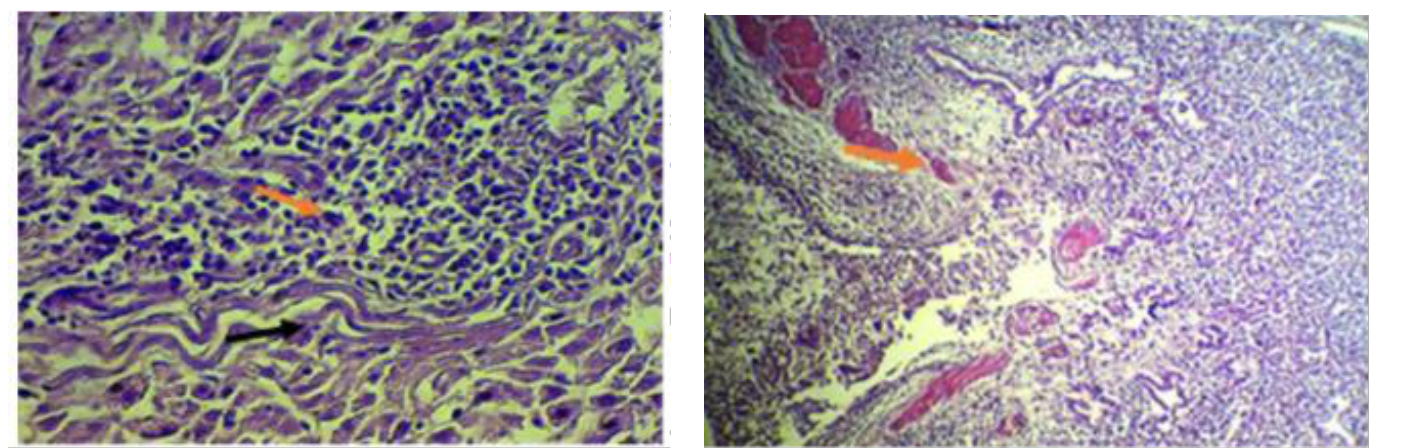
Figure 15. Histopathological section of liver shows mononuclear cells infiltration (